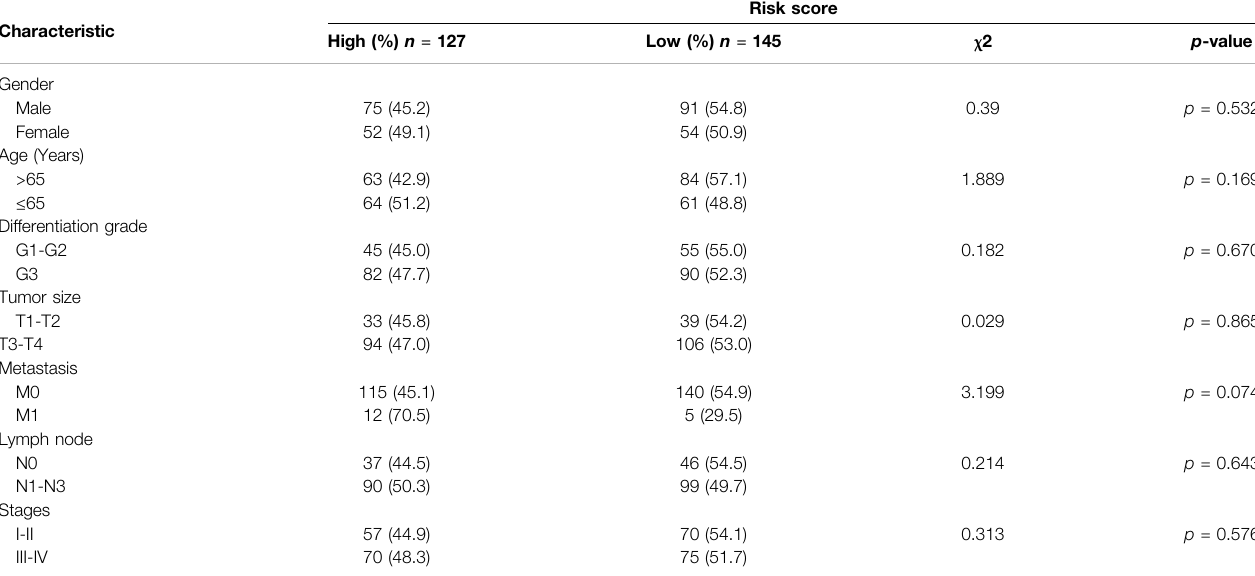
TABLE 1 | Correlations between risk and clinicopathologic characteristics of GC patients.